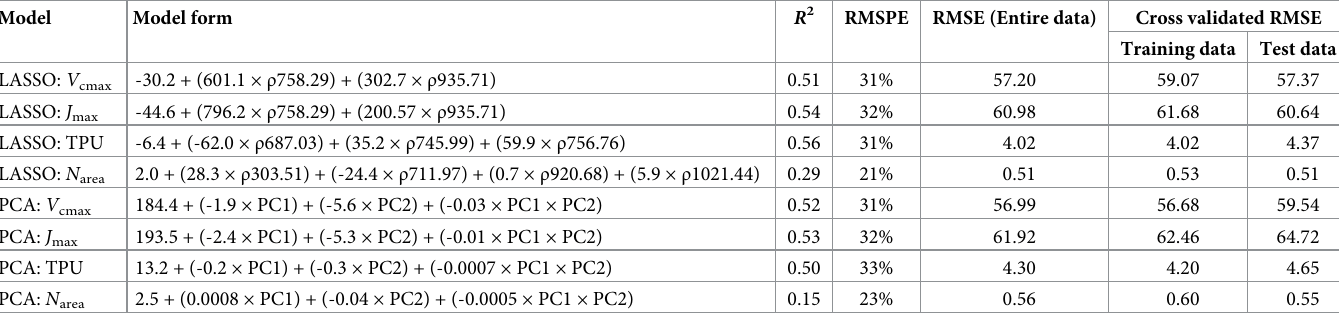
Table 2. Selected predictor variables in the models and averaged 10-fold cross validation results.